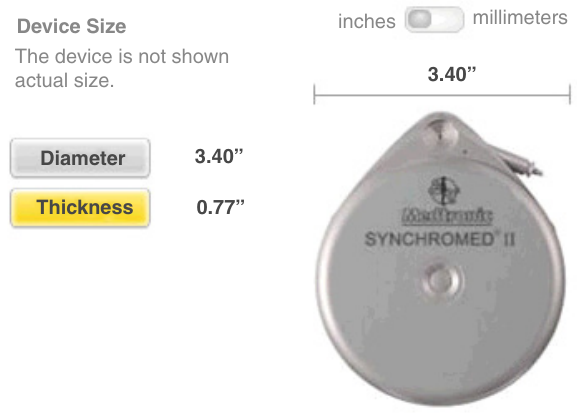
Figure 2. Image of the SynchroMed II Pump with specifications. Pump is programmable to deliver a specific amount of medication at different times and can be increased or decreased depending on the individuals needs. Reprinted with the permission of Medtronic, Inc.© 2009.